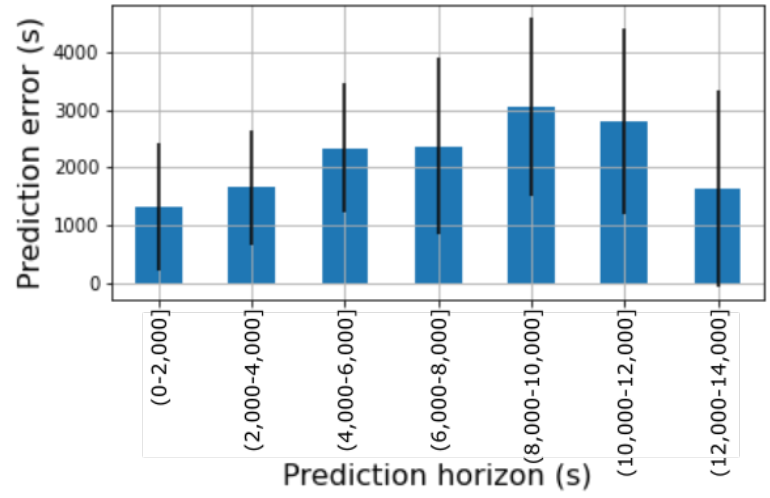
Figure 8. Residual error of the prediction model for different time horizons.